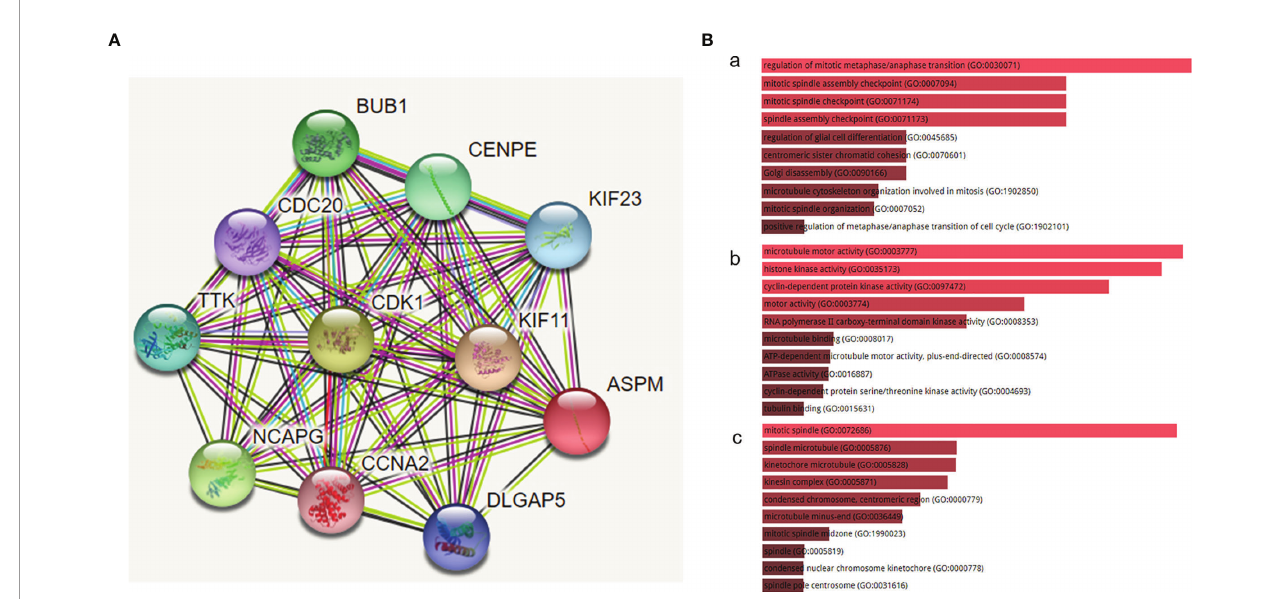
FIGURE 3 | The functional protein association network generated by the STRING database. (A) The network of ASPM and its co-expression genes was set up visually. (B) The biological functions (GO enrichment) of the identi fi ed genes via the Enrichr online database. (a) biological process, (b) molecular function, and (c) cellular component. The biological processes of these proteins mainly involved the regulation of mitotic metaphase/anaphase transition (GO:0030071), mitotic spindle assembly checkpoint (GO:0007094), and mitotic spindle checkpoint (GO:0071174). The molecular function term was mainly enriched in microtubule motor activity (GO:0003777), histone kinase activity (GO:0035173), and cyclin-dependent protein kinase activity (GO:0097472). The cell component term was signi fi cantly enriched in the mitotic spindle (GO:0072686), spindle microtubule (GO:0005876), and kinetochore microtubule